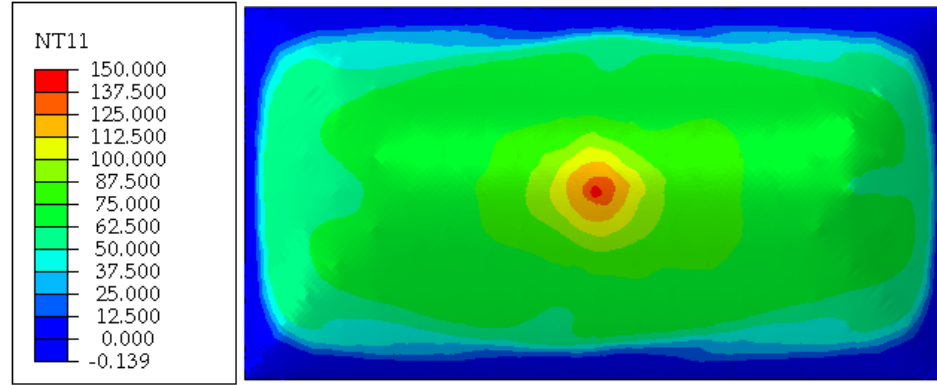
Figure 11. Temperature on the membrane structures.